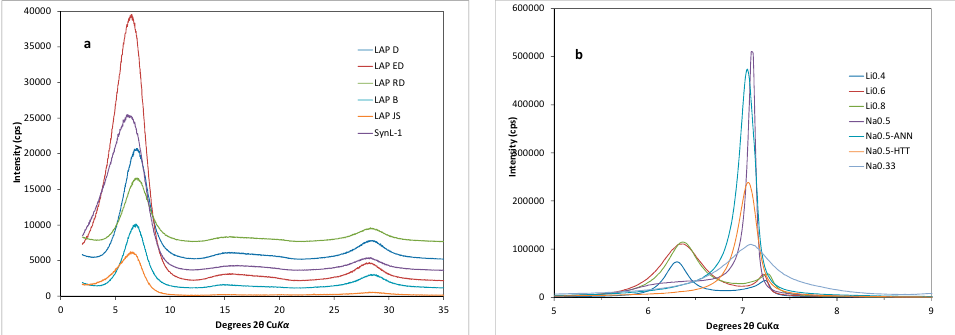
Figure 1. XRD traces of the air-dried synthetic Mg-Li smectites. ( a ) Samples from the first and second sample sets; and ( b ) samples from the third sample set.